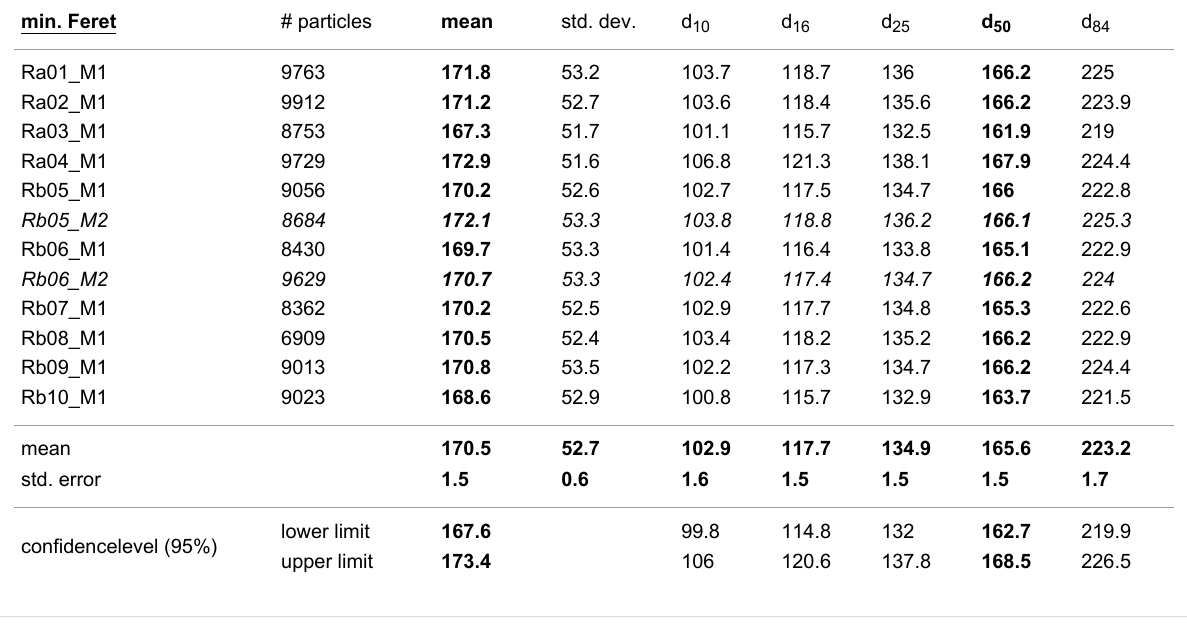
confidencelevel (95%)